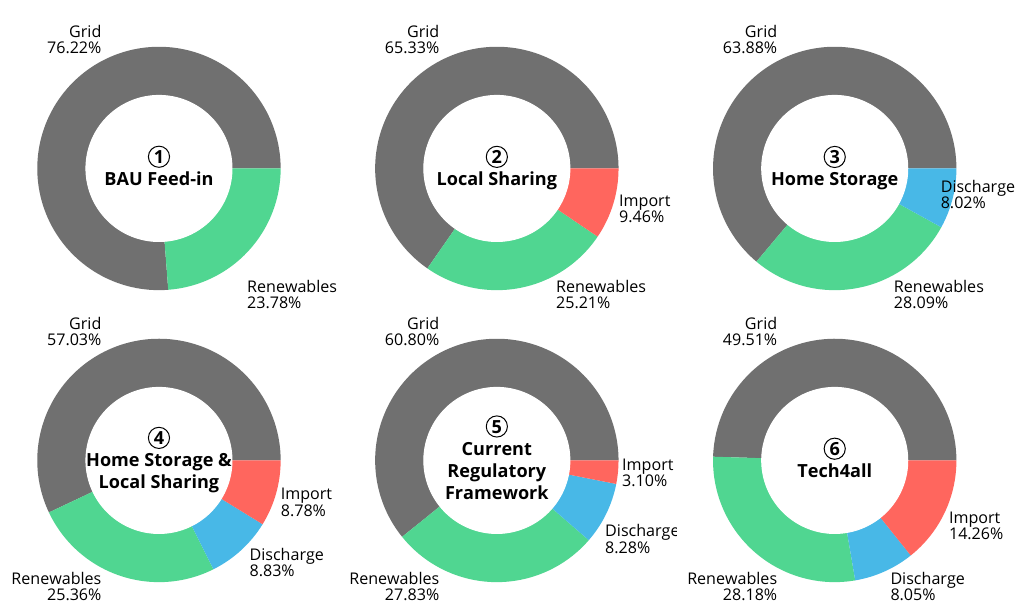
Figure 2. Overview of demand sources for the simulated market designs.